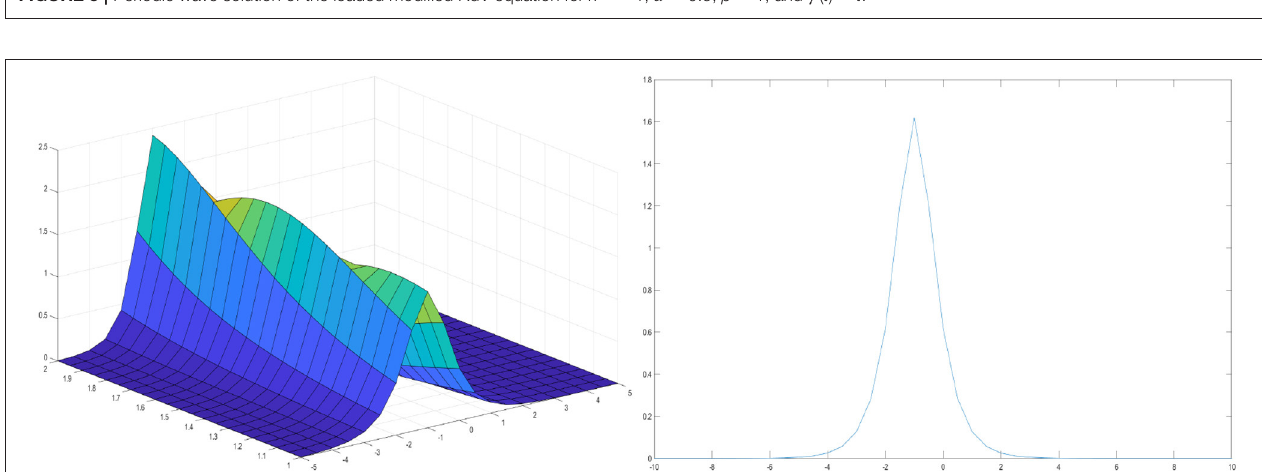
FIGURE 4 | Solitary wave solution of the loaded modified KdV equation for k